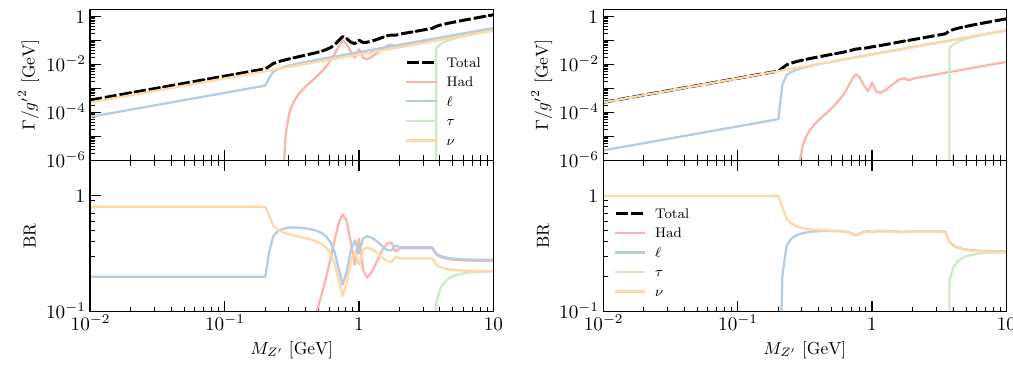
Figure 6 . Partial decay widths and branching ratios for the L µ − L τ Z 0 boson. Left: for r f = 0 . 5 . Right: for g e /g µ = 0 . 1 . See text for v v